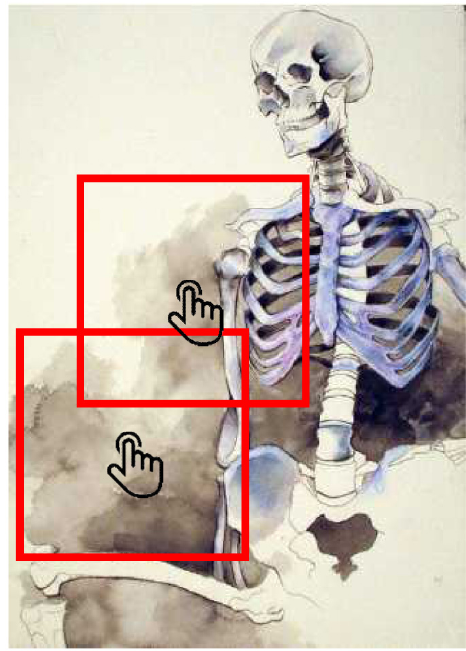
Figure 7. Example of gtPatch capturing. Regions selected by mechanical turks help recognize the artistic media of an artwork. Turks select at most three 256 × 256-size of patches from a single artwork